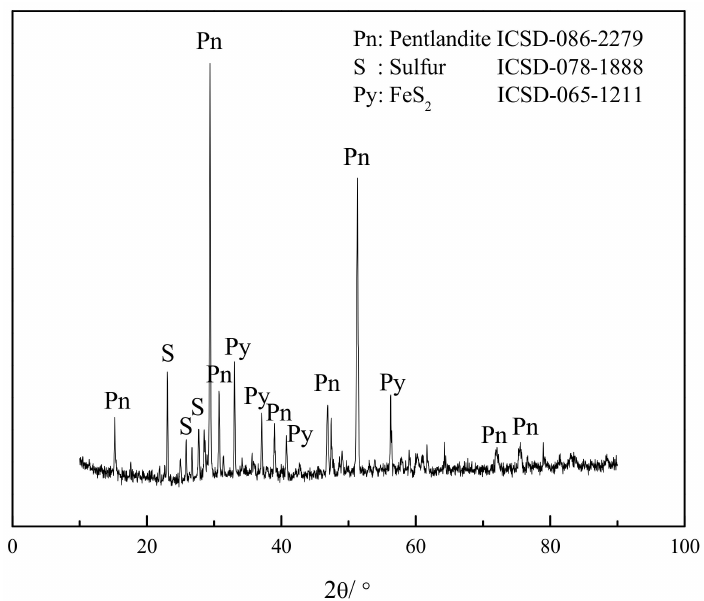
Figure 5. XRD pattern of leached sample (leached for 52 days with an initial Fe 3 + concentration of 7 g / L).